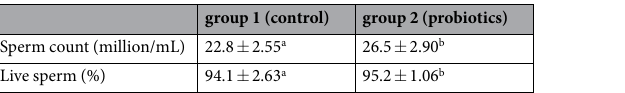
Table 5. Semen traits (mean ± SD). a,b Different letters within rows indicate differences between treatment groups ( p < 0.05).